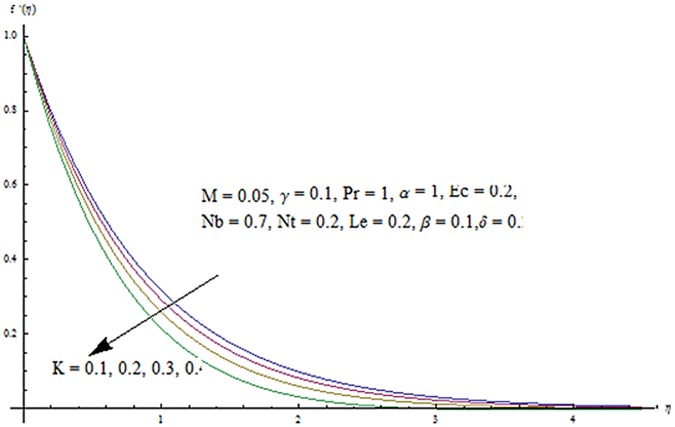
Influence of K on f′.